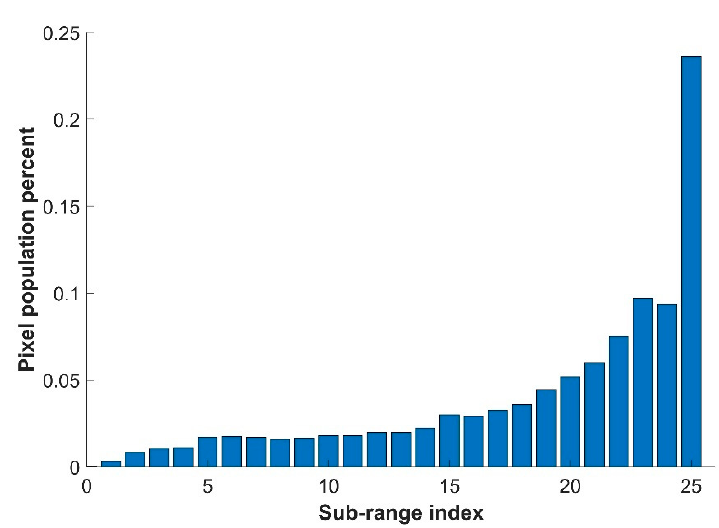
Figure 6. A typical pixel population for 25 intensity sub-ranges.